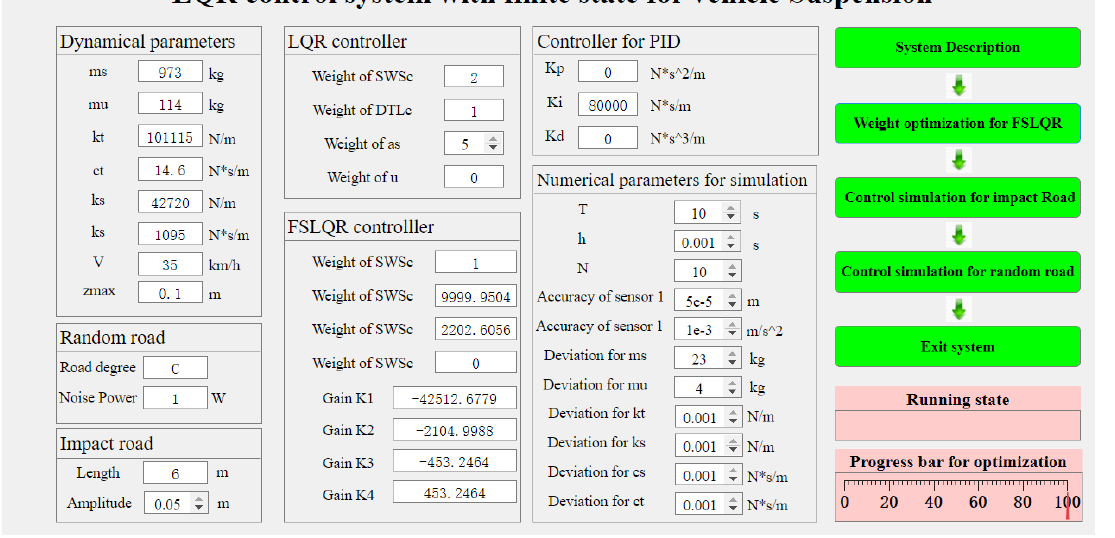
Figure 10. The establishment of LQR control system with finite state for vehicle suspension.